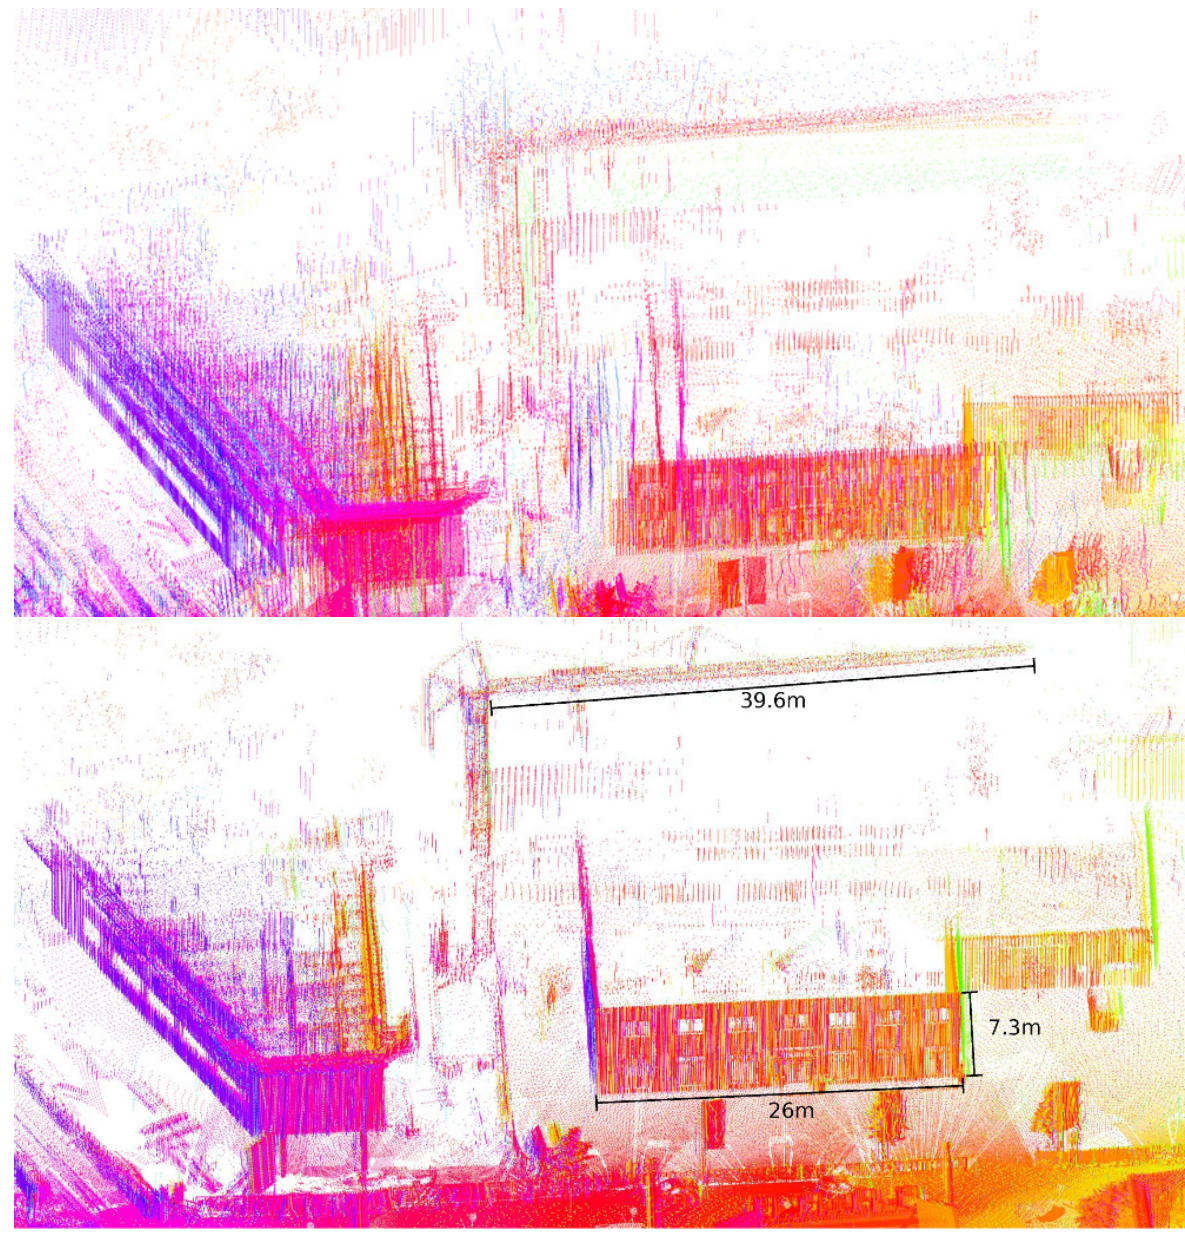
Figure 14. A more detailed view of the Salzburg dataset from Figure 13. The points are colored by their timestamps to provide contrast. The crane arm is approximately 42 m away from the trajectory. ( Top ) The initial point cloud. ( Bottom ) The optimized point cloud after processing with the semi-rigid registration